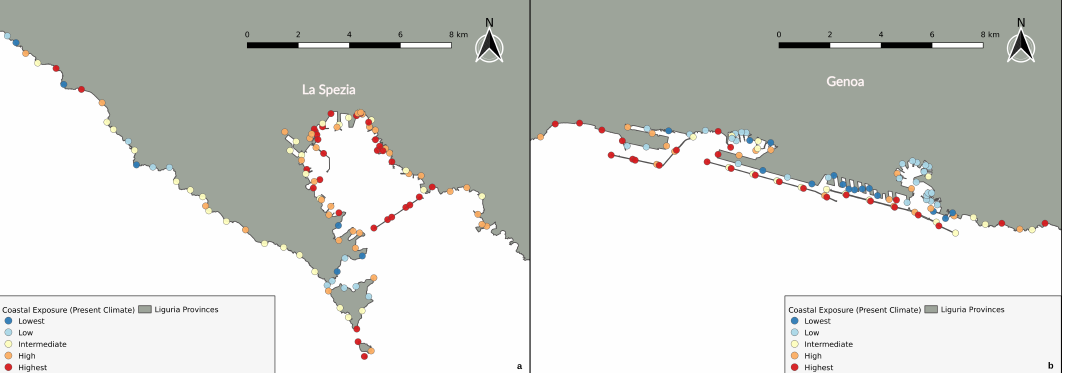
Figure 4. Map of the Exposure Index. Image zooms on the port areas of ( a ) La Spezia and ( b ) Genoa highlighting the location of the shore points on portal infrastructure. The location of the two areas within the broader regional context is highlighted in Figure 3. The shore points are styled in the same way as in the map of the whole area considered.